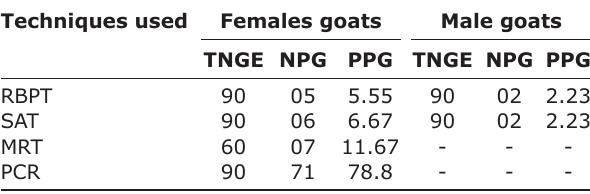
Table-1: Sex-wise diagnosis of brucellosis in goats determined by various techniques used during the experiments.